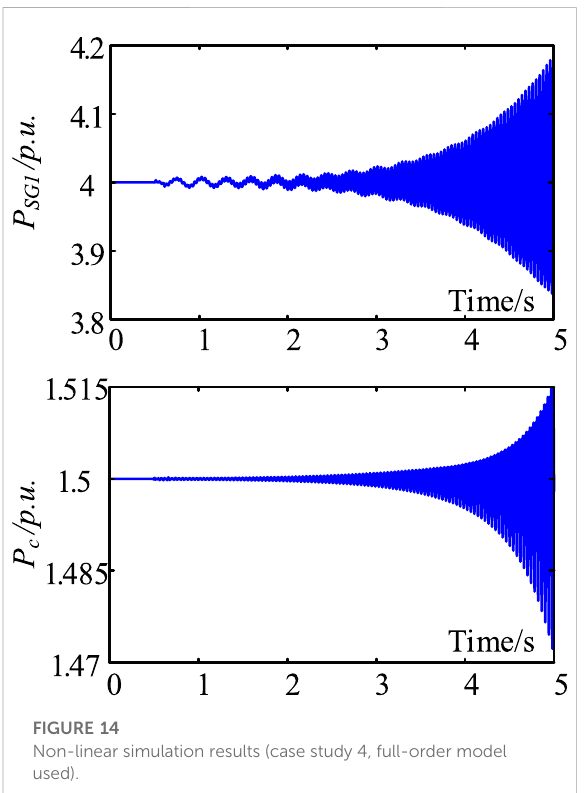
FIGURE 14 Non-linear simulation results (case study 4, full-order model